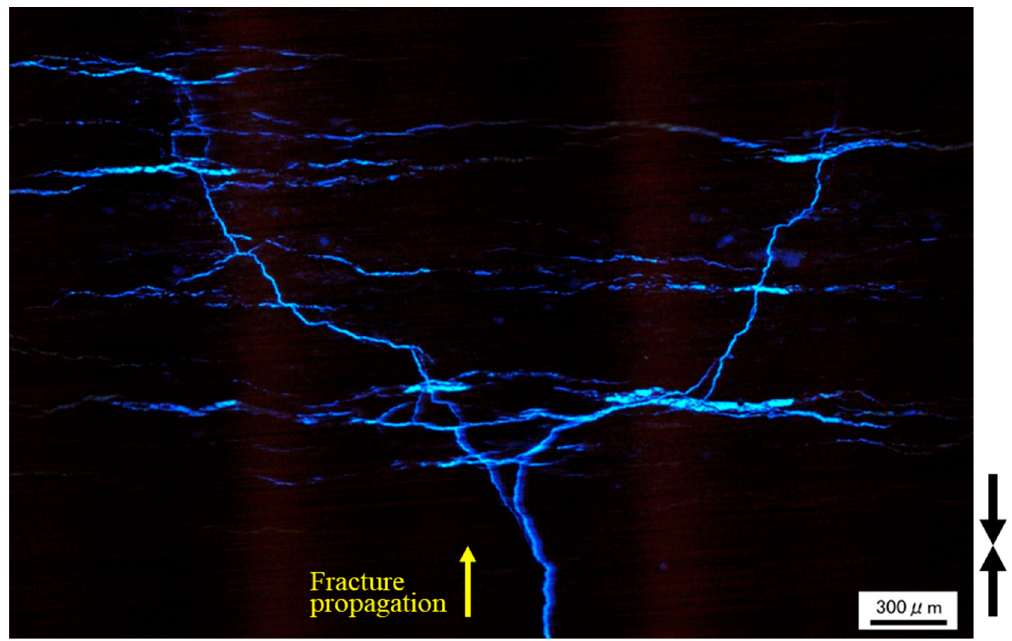
Figure 9. Observation of complex networks induced between hydraulic fractures and laminae in the Eagle Ford shale specimen under UV light. The pair of black arrows next to the figure represents the loading direction. The hydraulically induced fracture propagated along the loading direction and passed through the laminae after extending along and between them for short segments.